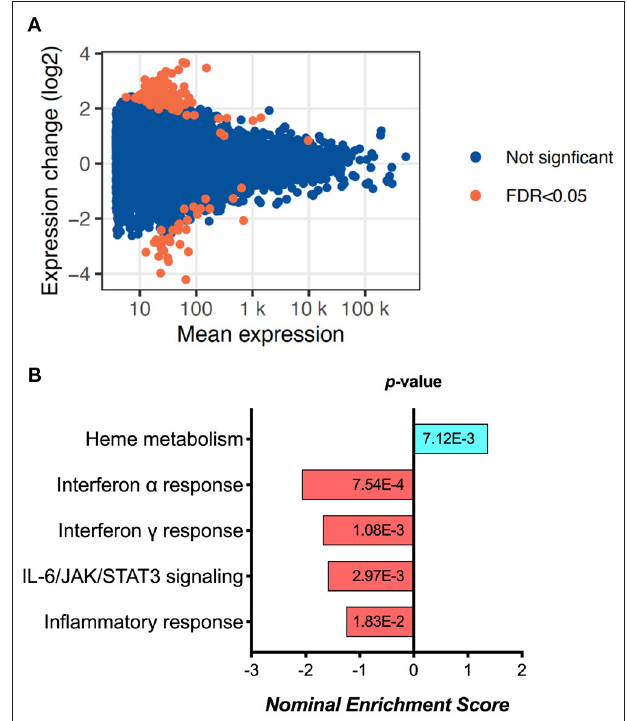
FIGURE 1 | RNA sequencing analysis results, showing (A) the MA plot visualizing the statistically different genes by transforming the data onto M (log ratio) and A (mean average) scales; and (B) the pathways significantly changed between day 0 and 6 months of ART based on Gene set enrichment analysis